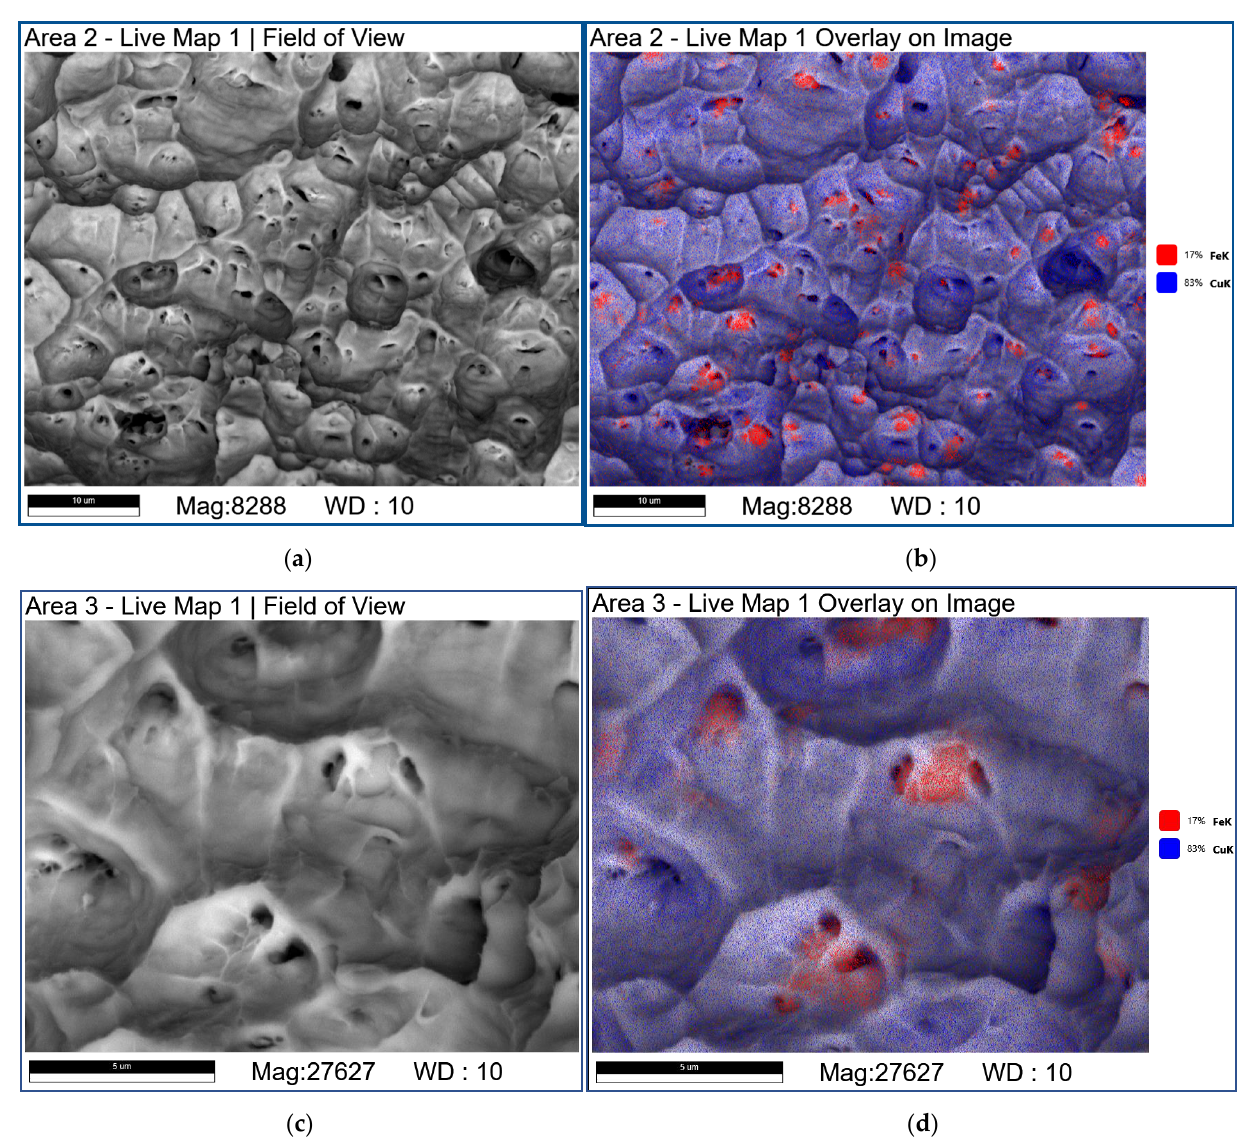
Figure 23. SEM BSE images ( a , c ) and layered EDS images ( b , d ) of the fracture surface “copper − steel” sample after tensile testing.